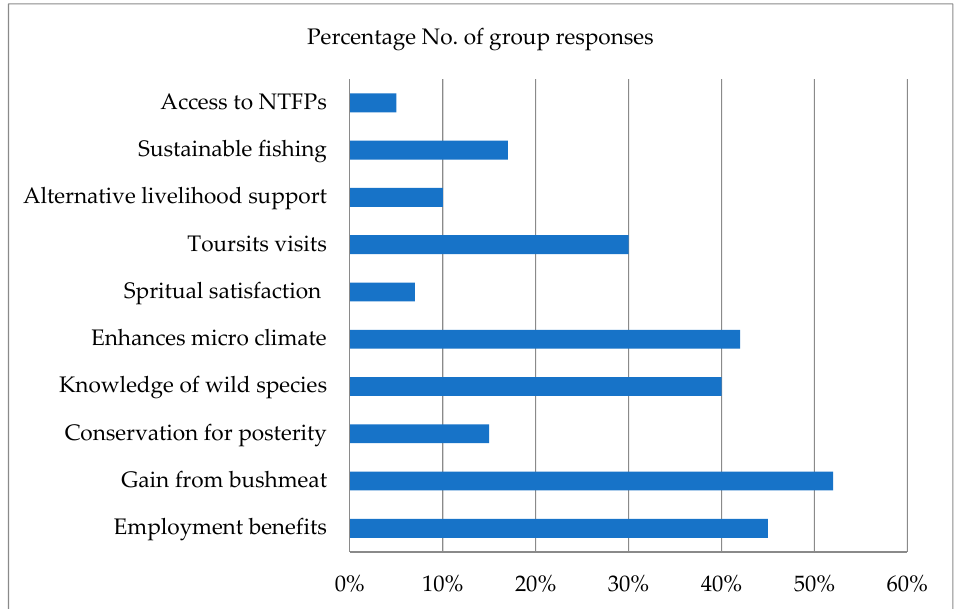
Figure 4. Benefits derived by Communities from the PAs. Source: Fieldwork (2016).